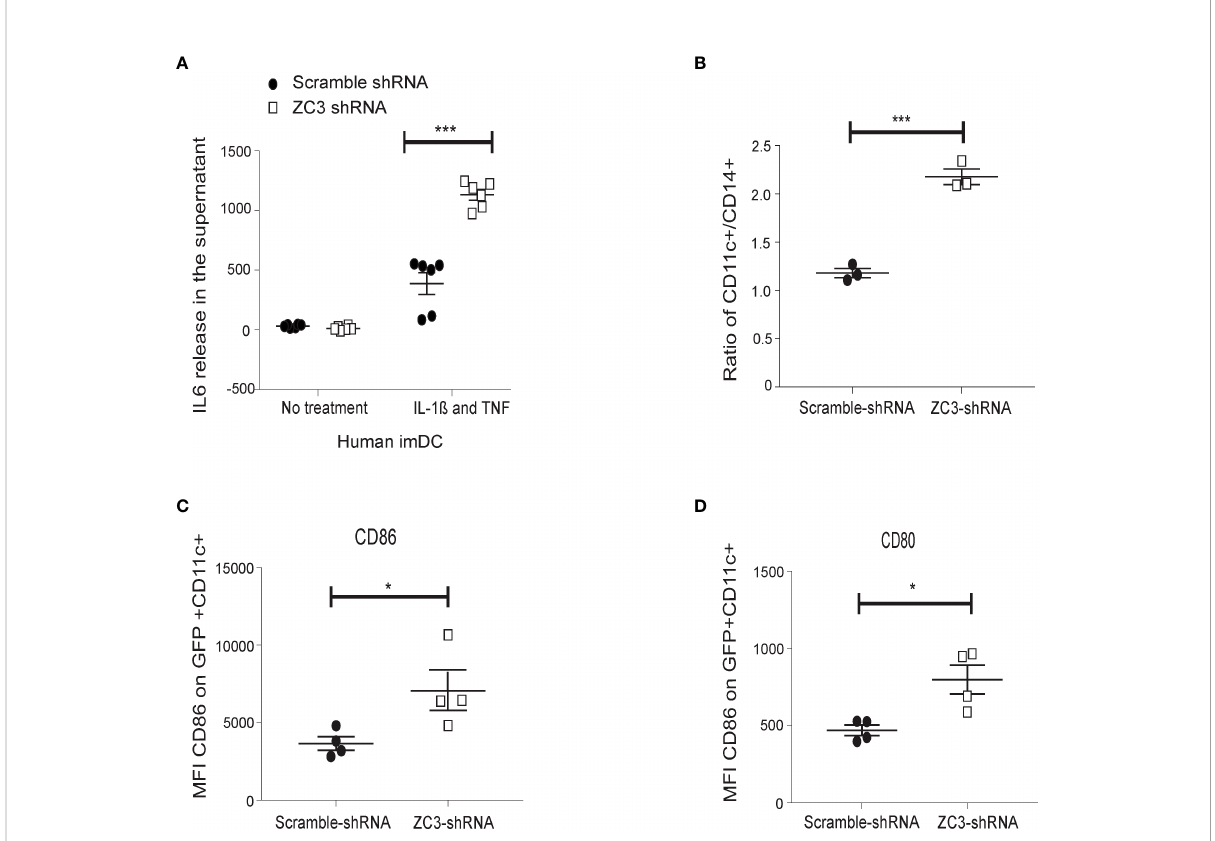
FIGURE 3 ZC3H11A depletion induces IL-6 expression in primary human dendritic cells, and enhances monocytes maturation into dendritic cells. (A) CD14 + monocytes were isolated by positive selection from PMBCs. Cells were transduced with a lentivirus expressing an shRNA-targeting ZC3H11A, or a lentivirus expressing a nonspeci fi c scrambled shRNA. IL-6 release was measured by ELISA from cells treated or not treated with an IL-1ß and TNF cocktail. The enhancement of dendritic maturation marker expression in the lentivirus-infected cells were followed by fl ow cytometry; CD11c (B) , CD86 (C) , and CD80 (D) marker expression. The data are presented as the mean ± SEM values. *P < 0.05; ***P <